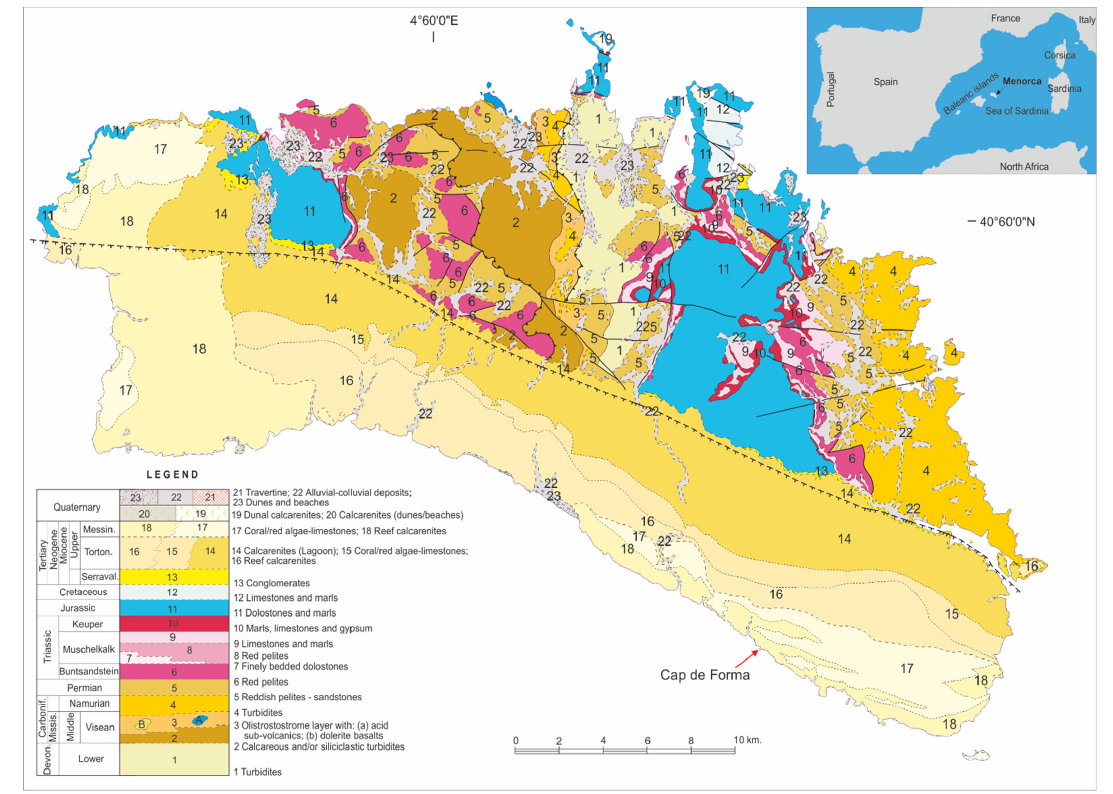
Figure 3. Geological map of Minorca Island at scale 1:100.000. Modified from: [51]. Source ©Insti ‐ tuto Geológico y Minero de España (IGME).